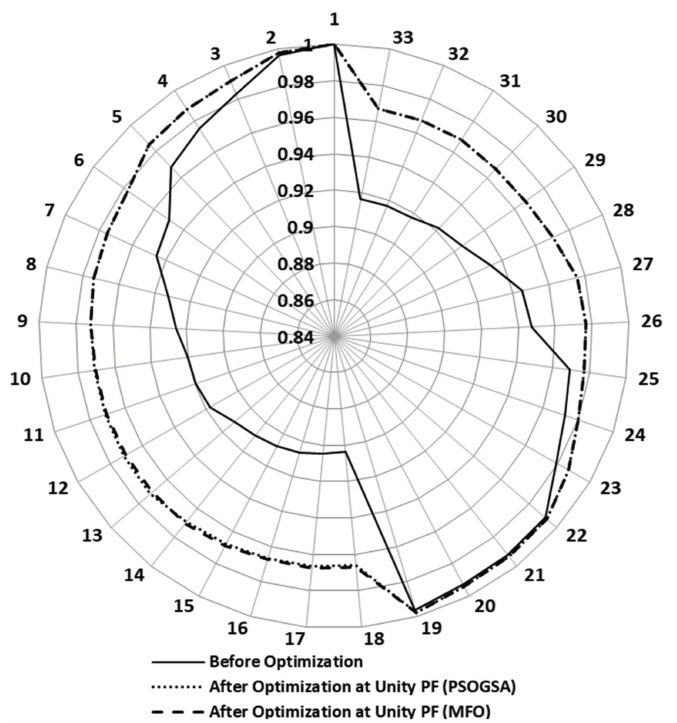
Figure 14. The impact of compensated devices on voltage profile for 33-bus IEEE system at unity PF.